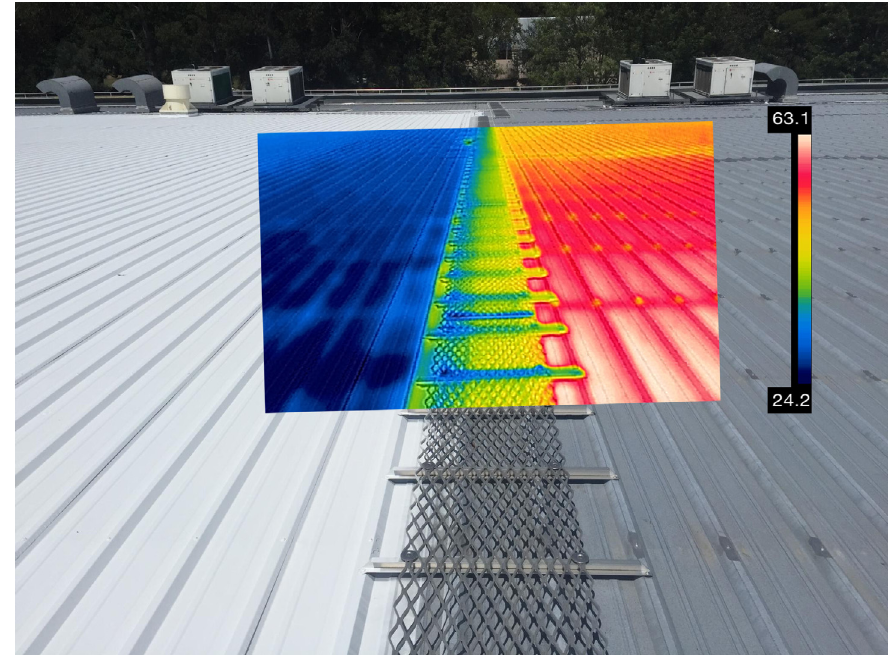
Fig. 2. A cool, diffuse, high albedo roof (left) which has high IR absorptance at wavelengths across the Planck thermal spectrum for all exit directions compared to an original galvanized lower E , lower albedo fi nish, smoother, much hotter roof (right), which clearly has a large variation in E ( u ) as u varies (its higher T is fi